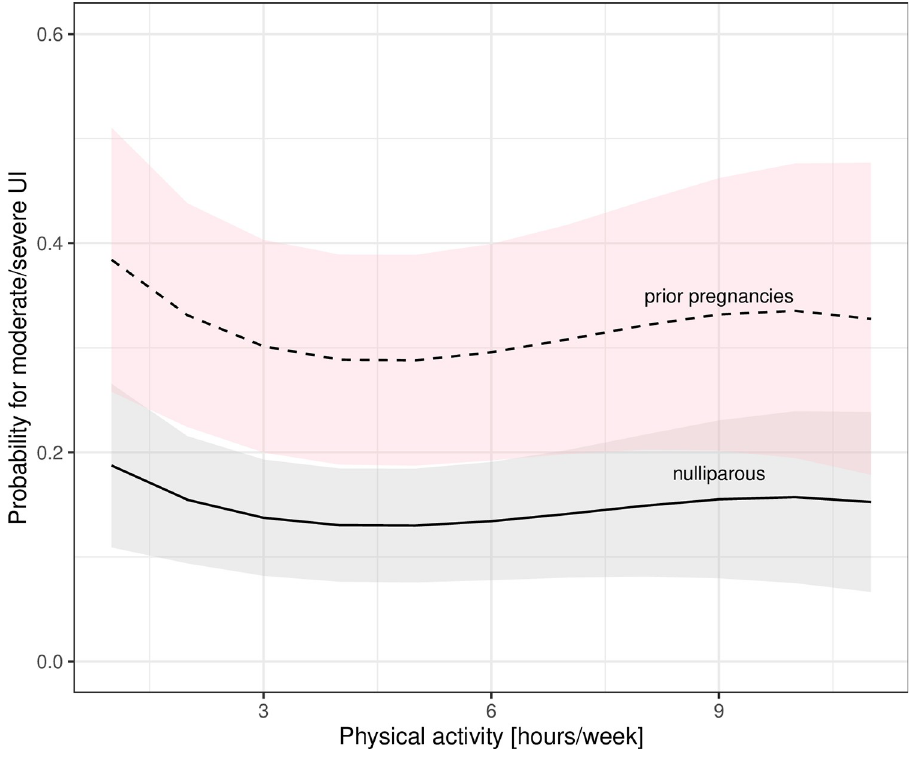
Fig 3. Predicted probability of UI with concurrent